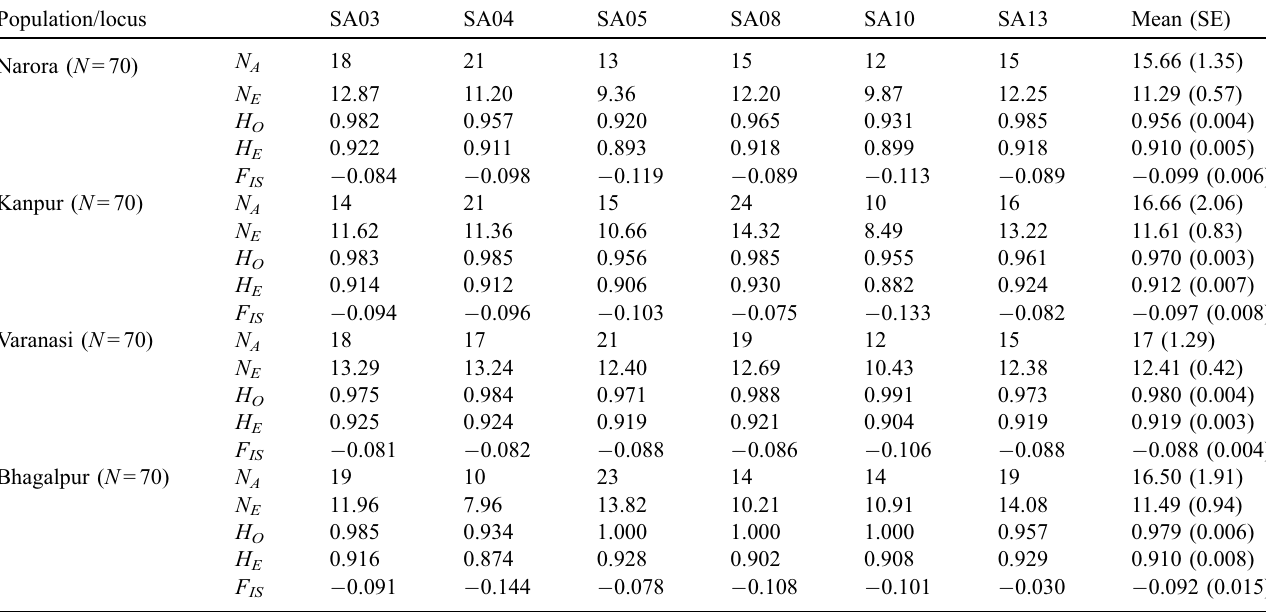
Table 2. Genetic diversity population statistics across six microsatellite loci and four populations: number of alleles ( N A ); number of effective alleles ( N E ); observed ( H O ) and expected ( H E ) heterozygosity; inbreeding coef fi cient ( F IS ). Population/locus